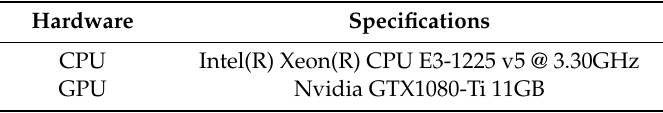
Table 3. The hardware specifications used in the experiments.